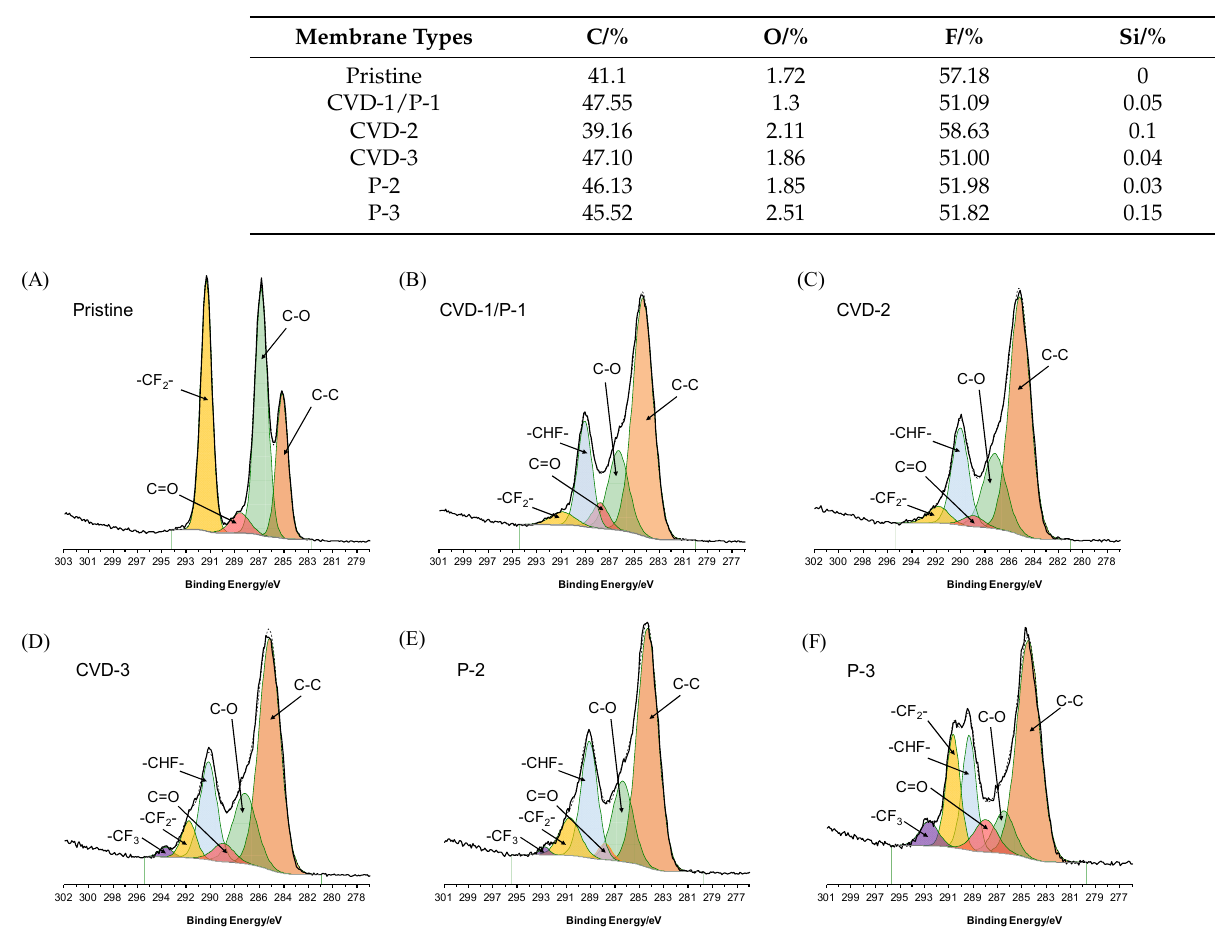
Table 1. The element ratio of different CVD and plasma treatment times modified membranes.